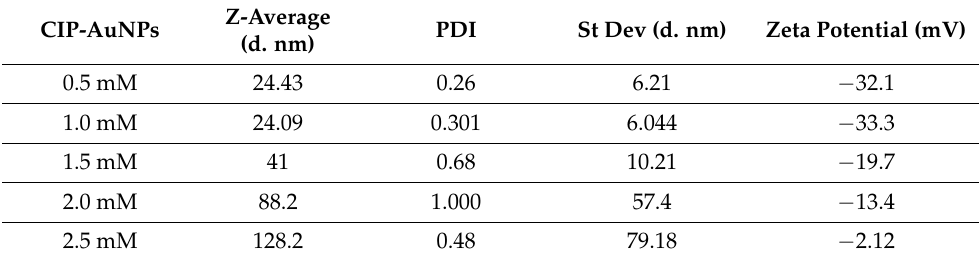
Table 2. Zeta potential values for CIP-AuNPs, AuNPs, and CIP. CIP-AuNPs